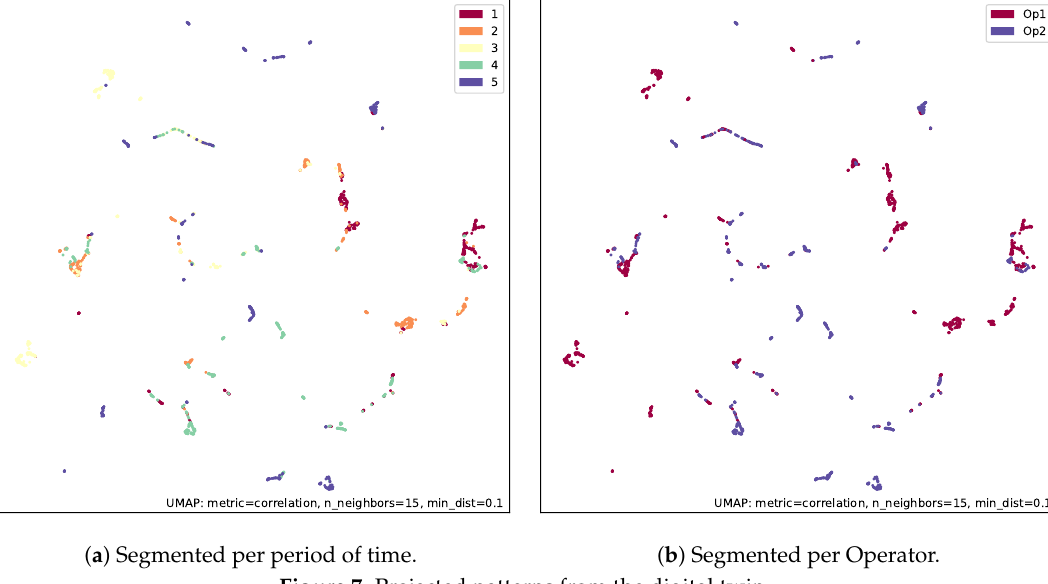
Figure 7. Projected patterns from the digital